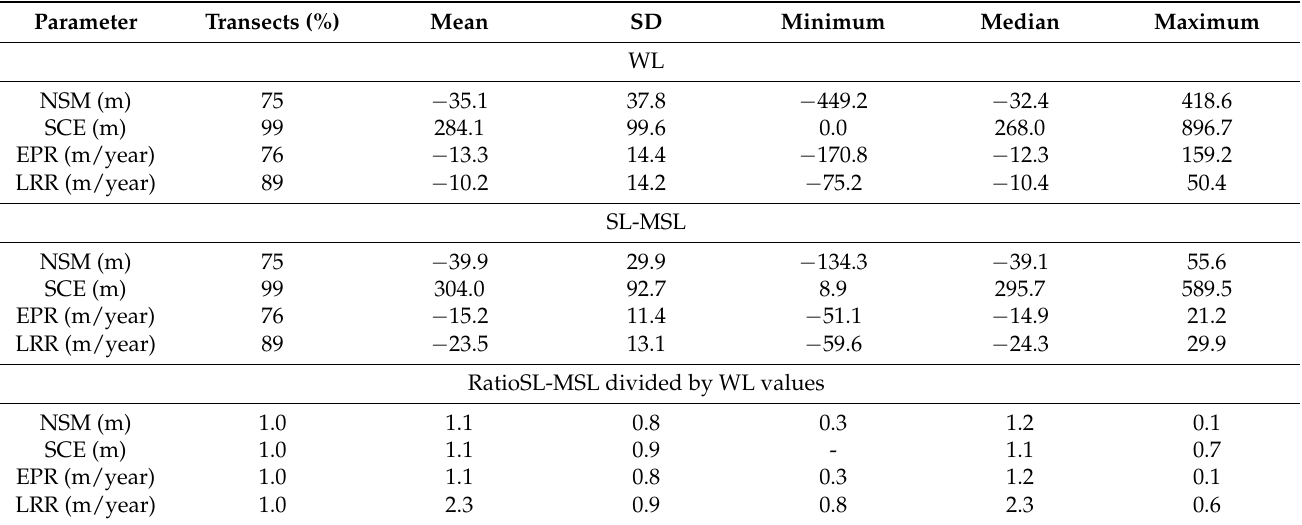
Table 6. NSM, EPR, SCE, and LRR results for period between 2017–2020 at Spurn Head (Site #1) using MSI-WL and MSI-SL-MSL.